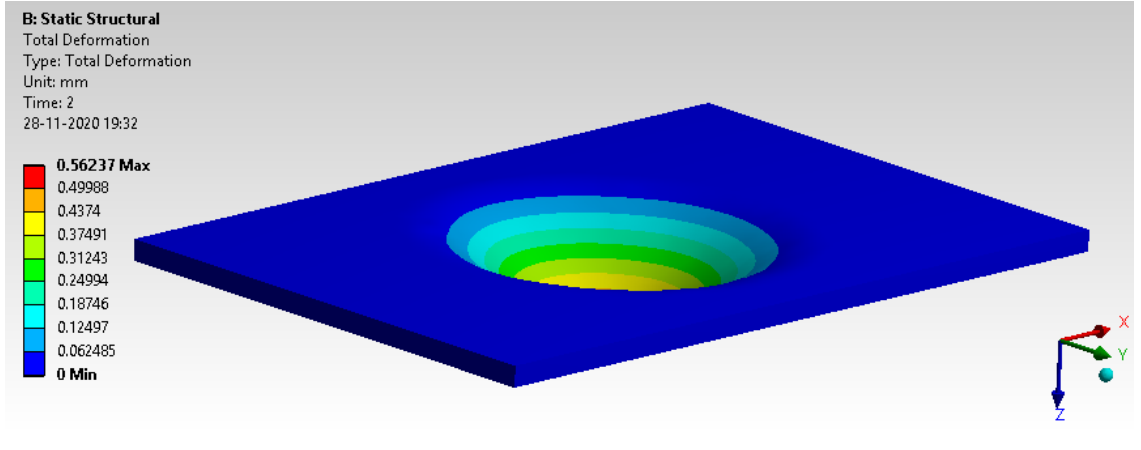
Figure 18. Total deformation.